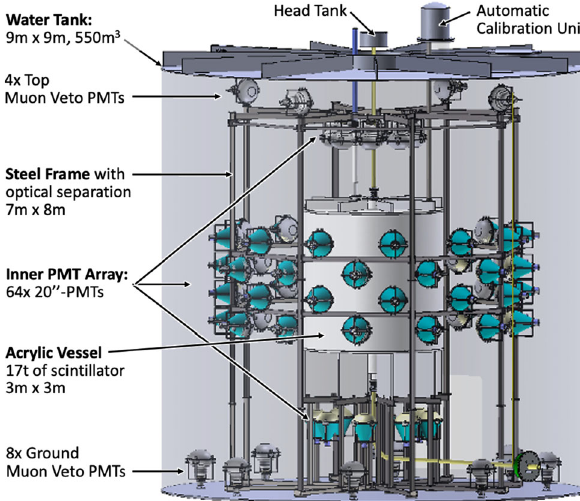
Fig. 2 Layout of the OSIRIS detector. The detector is segregated into the Inner Detector (ID) that is formed by the LS volume and the inner PMT array and the Outer Detector (OD) that uses the shielding water as a Cherenkov muon